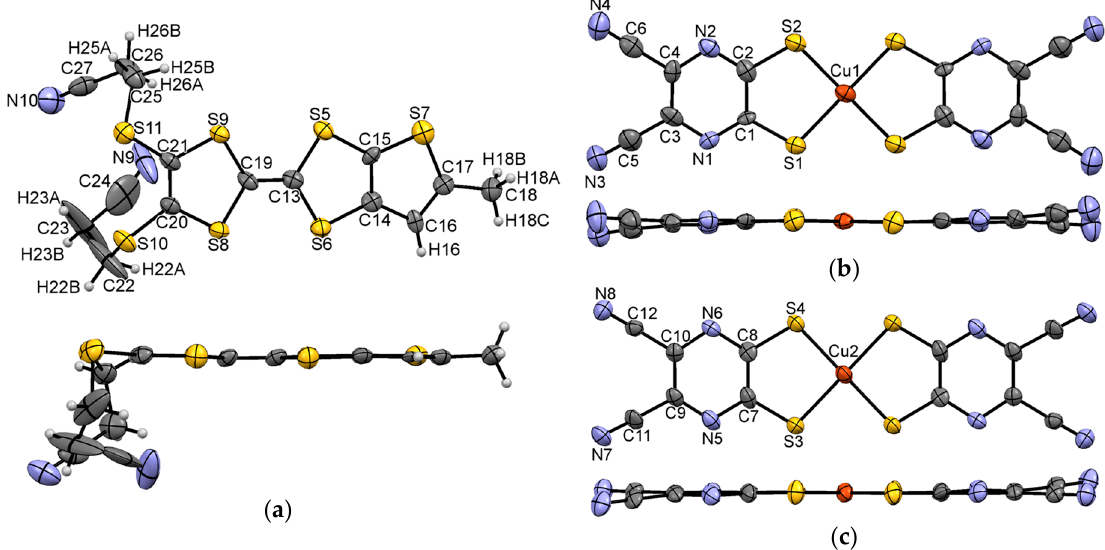
Figure 7. ORTEP and atomic numbering schemes (top and side views) of α -mtdt donor ( a ) and acceptor [Cu(dcdmp) 2 ] molecules A ( b ) and B ( c ) in the crystal structure of ( α -mtdt)[Cu(dcdmp) 2 ] ( 7 ), with thermal ellipsoids drawn at 50% probability level.